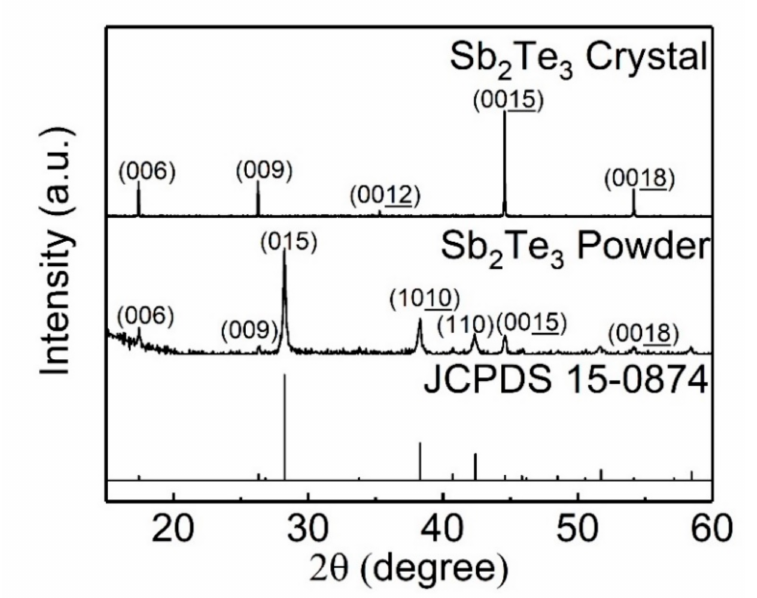
Figure 1. The X-ray diffraction (XRD) pattern of the produced Sb 2 Te 3 . The sharp peaks indicate that the Sb 2 Te 3 is highly single crystalline. The Sb 2 Te 3 powder was ground from the Sb 2 Te 3 crystal. The XRD pattern of the Sb 2 Te 3 powder is consistent with the JCPDS